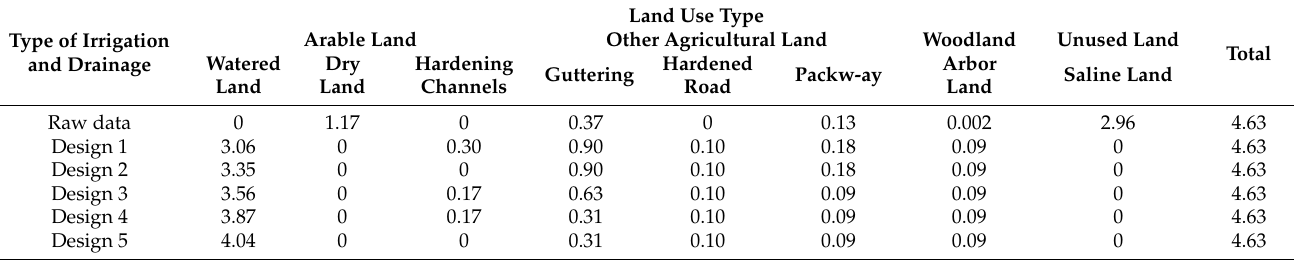
Table 5. Land use of different irrigation and drainage patterns. Unit: km 2